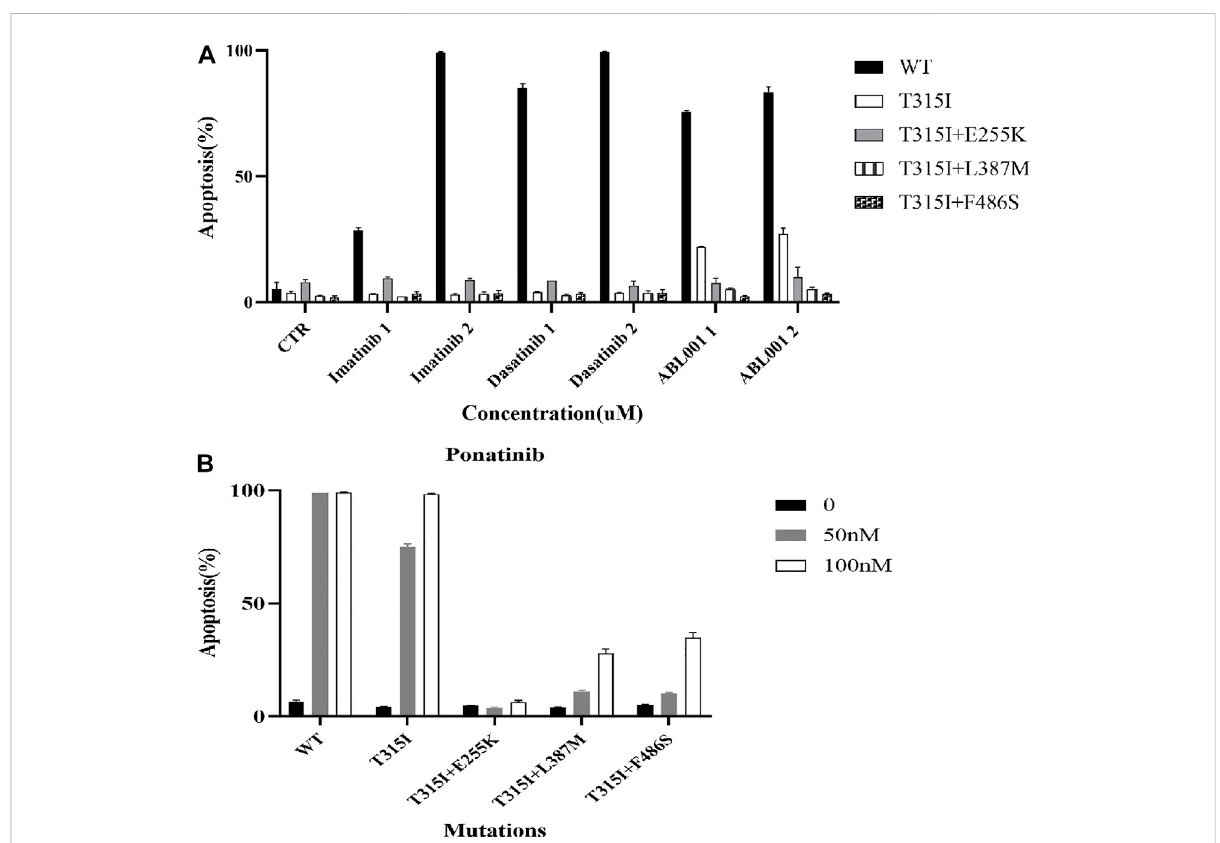
FIGURE 2 Effects of ABL1 inhibitors on promoting apoptosis of Ba/F3-MIG-p210 cells with BCR::ABL1 mutants were weakened. The apoptosis of Ba/F3- MIG-p210cellstreatedwith differentABL1inhibitorsfor 48 hwasdetected viaannexin V-647 and7-AADdoublestaining: (A) Imatinib,dasatinib, and ABL001;theabscissamarksthenamesandconcentrationsofagents,andtheordinateistheapoptosis rate;thecolorsofthebargraphrepresentthe BCR::ABL1 wildtype (WT) or differentmutantscarried by Ba/F3-MIG-p210cells, including BCR::ABL1 T315I , BCR::ABL1 T315I+E255K , BCR::ABL1 T315I+L387M , andBCR::ABL1 T315I+F486S . (B) Ponatinib;theabscissamarkstheBCR::ABL1 WT ,ordifferentmutantscarriedbyBa/F3-MIG-p210cells,andtheordinateis the apoptosis rate; the colors of the bar graph represent different concentrations of